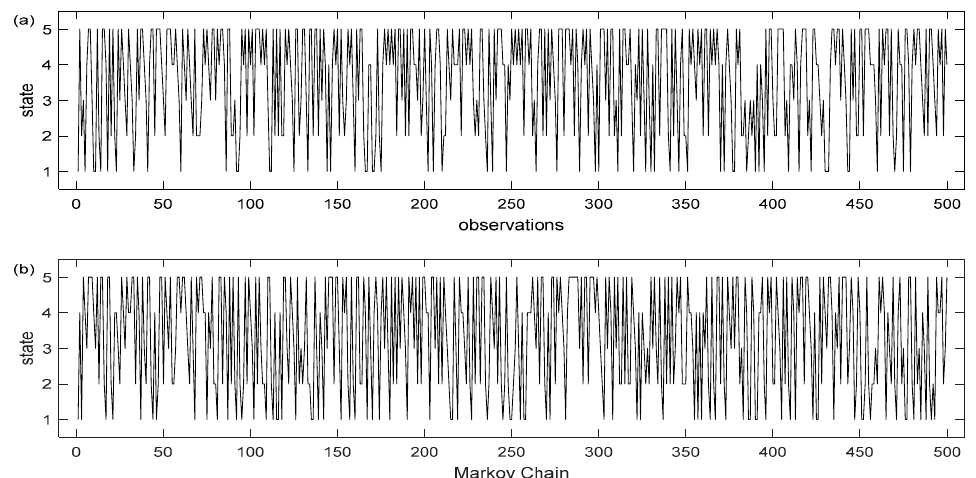
Figure 4. ( a ): Long term sequence of observation of the mosquito population process having five states, ( b ): realization of a Markov chain trained model on these observations, (state 1: very low mosquito population, state 2: low mosquito population, state 3: moderate mosquito population, state 4: high mosquito population, state 5: very high mosquito population). Each time period corre- sponds to an observation for a finite number of successive seasons. The initial state at time 0 corre-